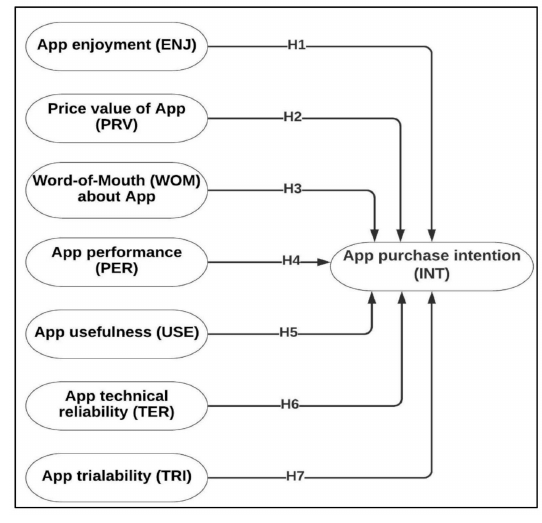
Figure 1. The research